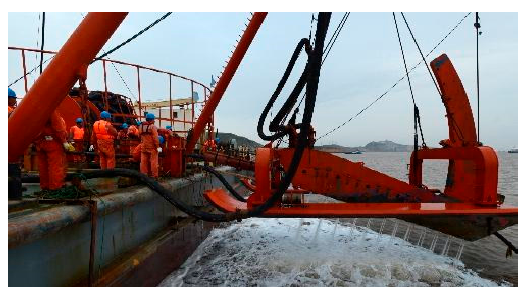
Figure 2. The hydraulic jet submarine cable laying machine.